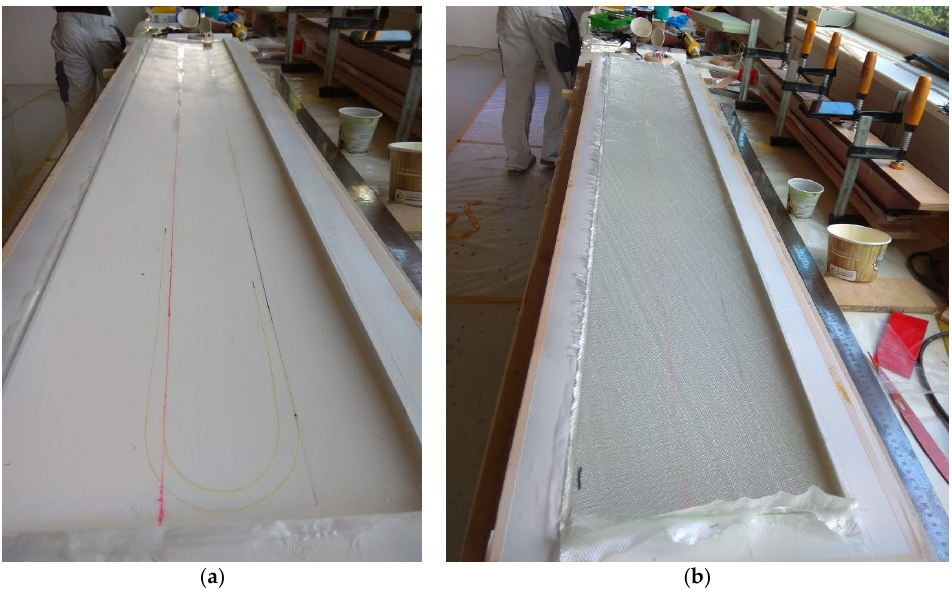
Figure 18. Placement of the strain fiber ( a ) and a 15° unidirectional (UD) glass layer ( b ).